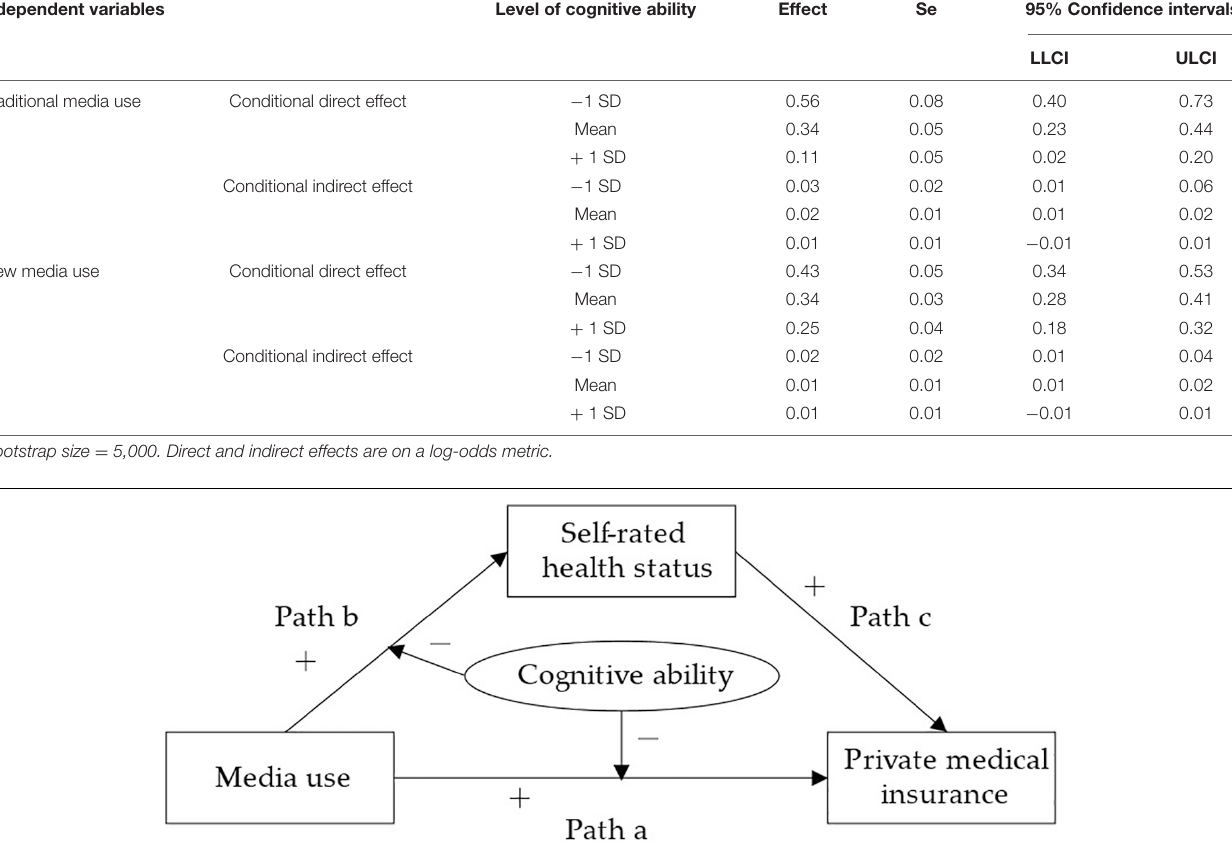
TABLE 7 | Conditional direct and conditional indirect effects of media use on the purchase of private medical insurance. Independent variables